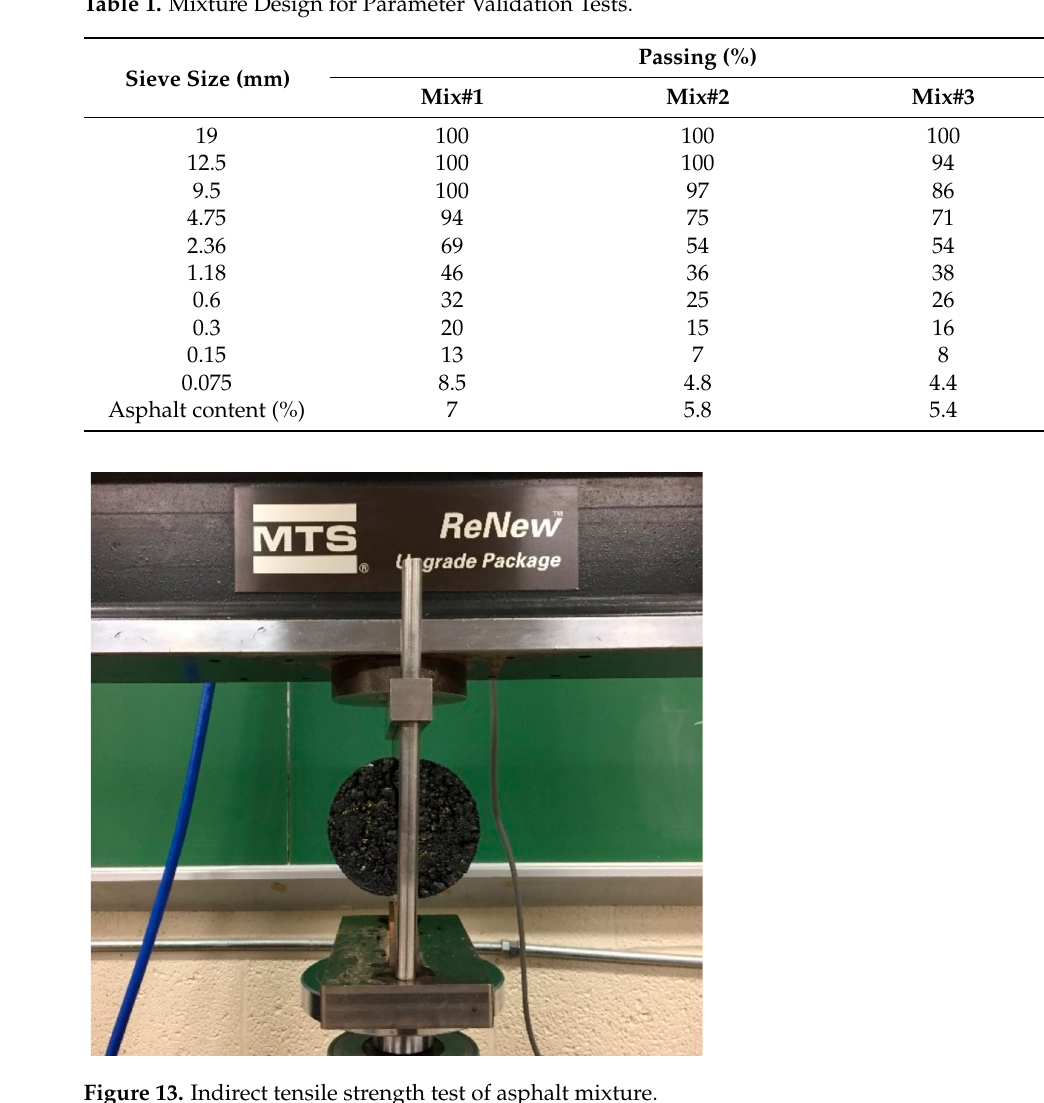
Table 1. Mixture Design for Parameter Validation Tests.